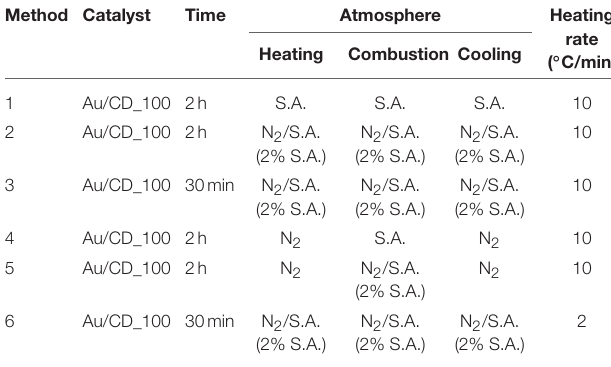
TABLE 2 | Tested calcination process over Au/CD_100